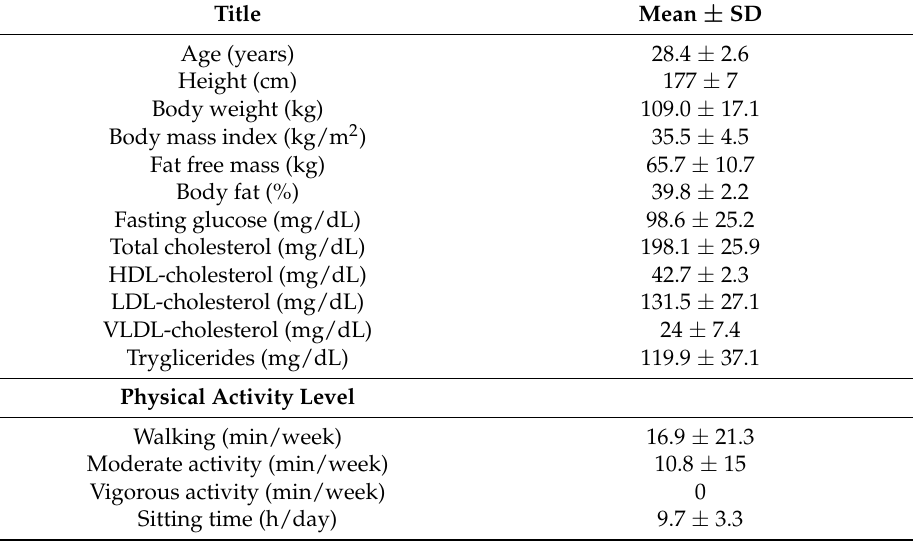
Figure 2. Selection flowchart of participants. Table 1. Characteristics of the sample ( n = 12).